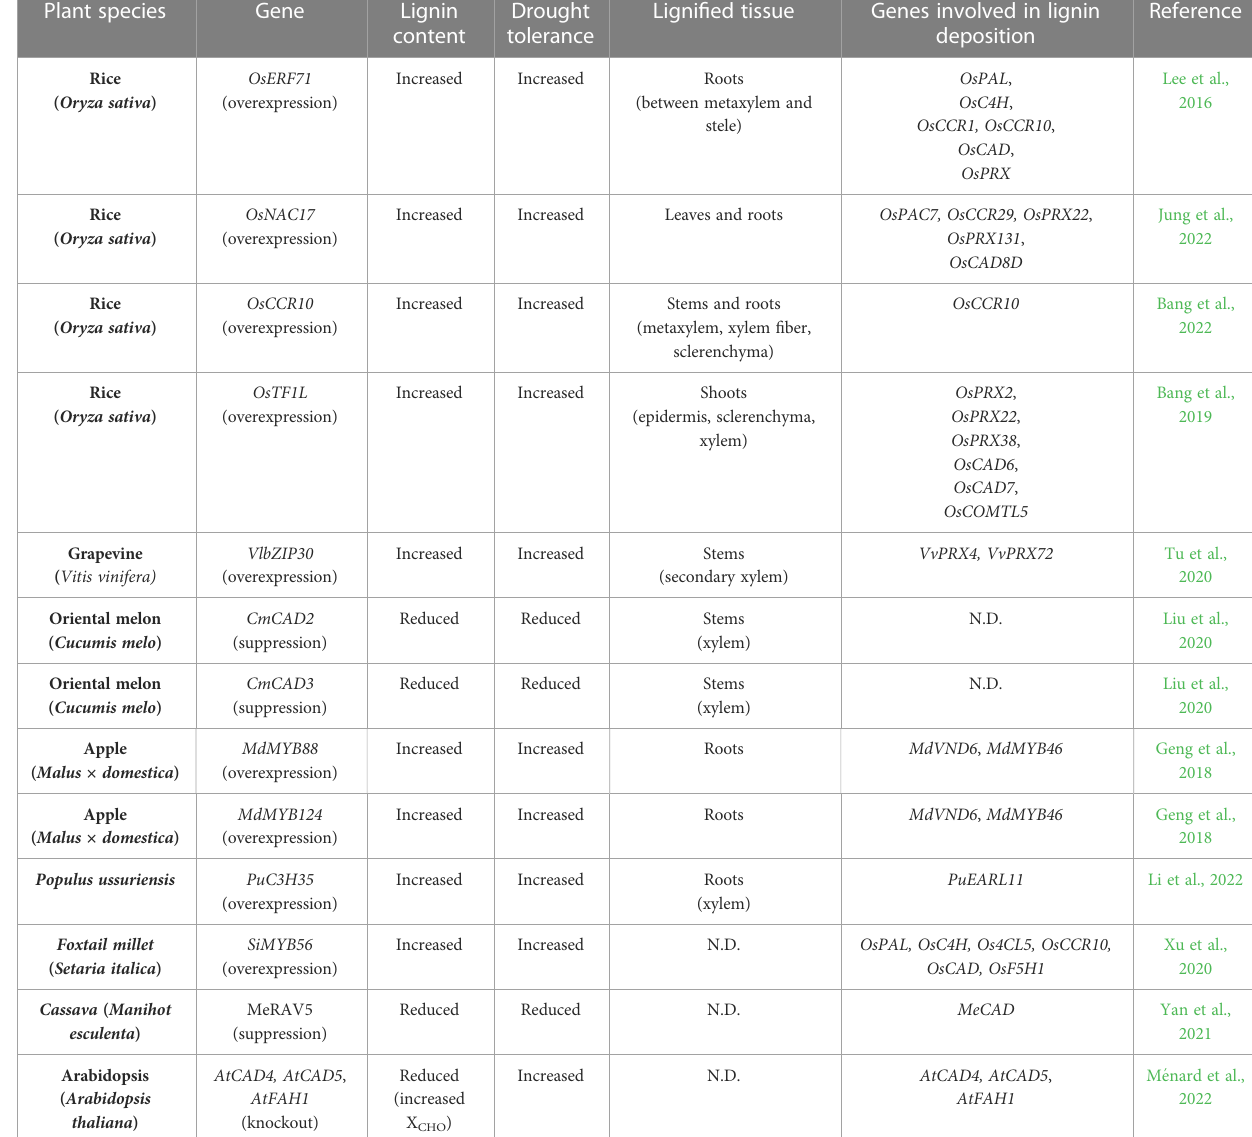
TABLE 2 Modi fi cation of lignin deposition and its effect on drought tolerance. Plant